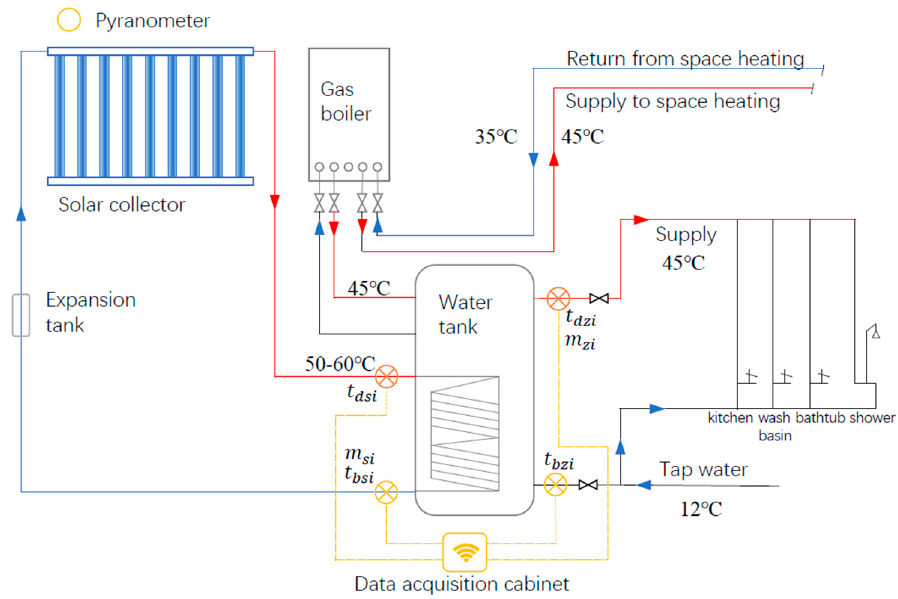
Figure 10. System schematic.